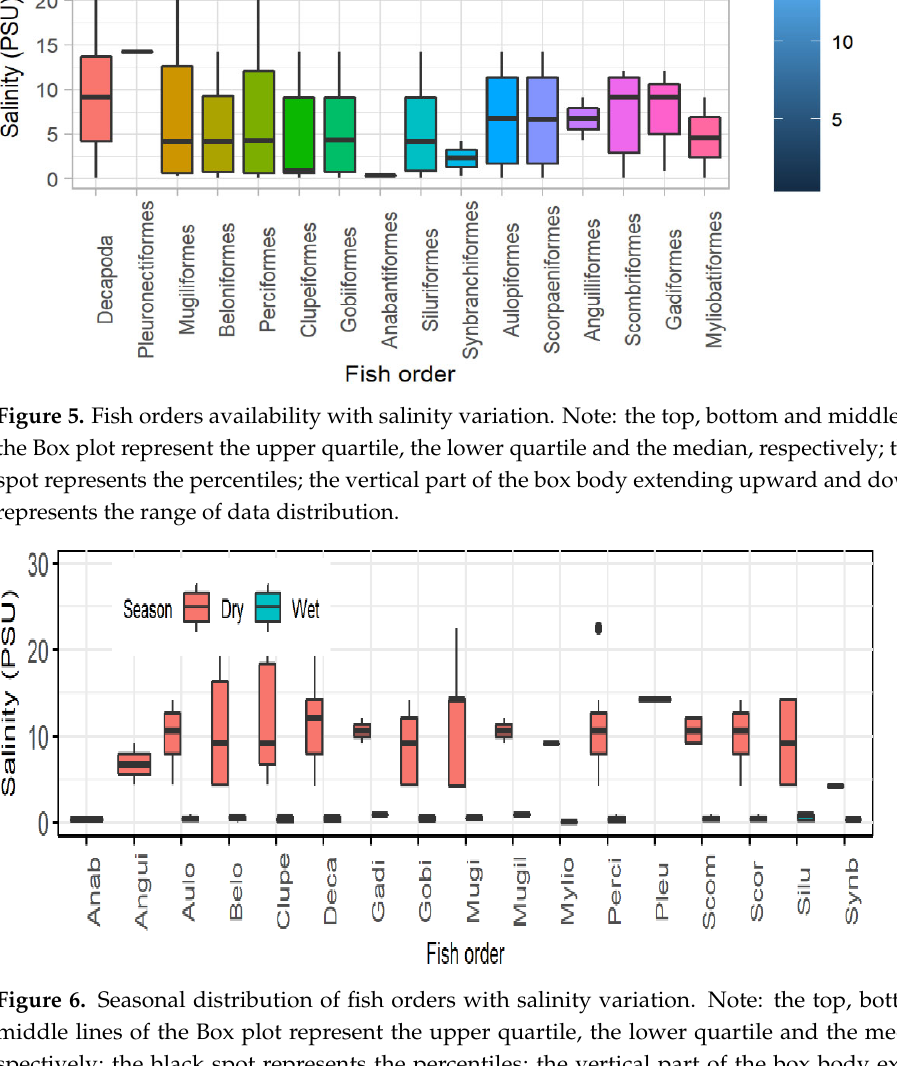
Figure 6. Seasonal distribution of fish orders with salinity variation. Note: the top, bottom and middle lines of the Box plot represent the upper quartile, the lower quartile and the median, re- spectively; the black spot represents the percentiles; the vertical part of the box body extending upward and downward represents the range of data distribution (Anab: Anabantiformes, Angui: Anguiliformes, Aulo: Aulopi-formes, Belo: Beloniformes, Clupe: Clupeiformes, Deca: Decapoda, Gadi: Gadiformes, Gobi: Gobiiformes, Mugil: Mugiliformes, Mylio: Myliobatiformes, Perci: Perci- formes, Pleu: Pleuronectiformes, Scom: Scombriformes, Scor: Scorpaeniformes, Silu: Siluriformes, Synb: Synbranchiformes).